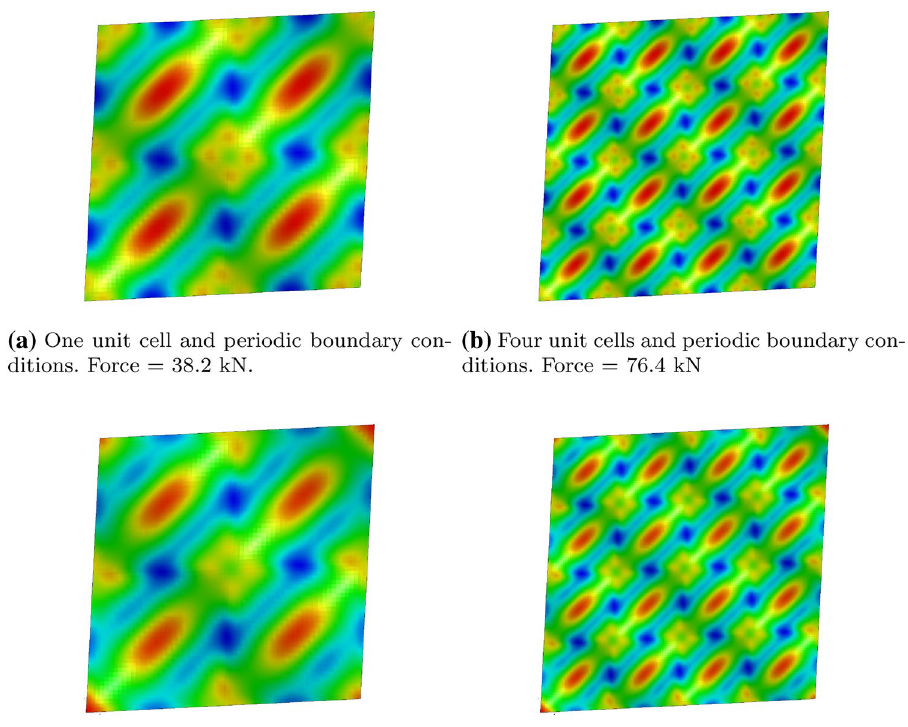
Fig. 10 In-plane shear stress is illustrated for the Type A RVE where a comparison between periodic and homogeneous boundary conditions is made under in-plane shear loading